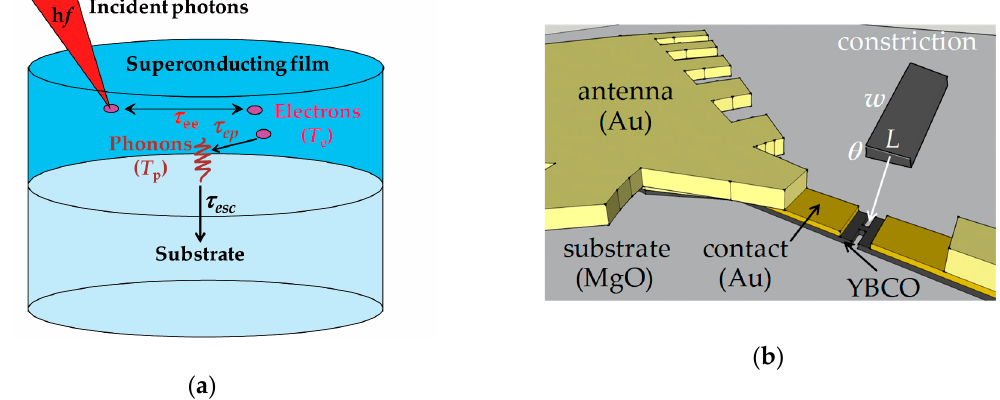
Figure 1. Superconducting hot electron bolometers (HEB): ( a ) Illustration of the point bolometer thermal model with two-reservoirs (electrons and phonons of the superconductor); ( b ) Sketch of a YBCO HEB constriction (of length L , width w , and thickness θ ) connected to the arms of a THz planar